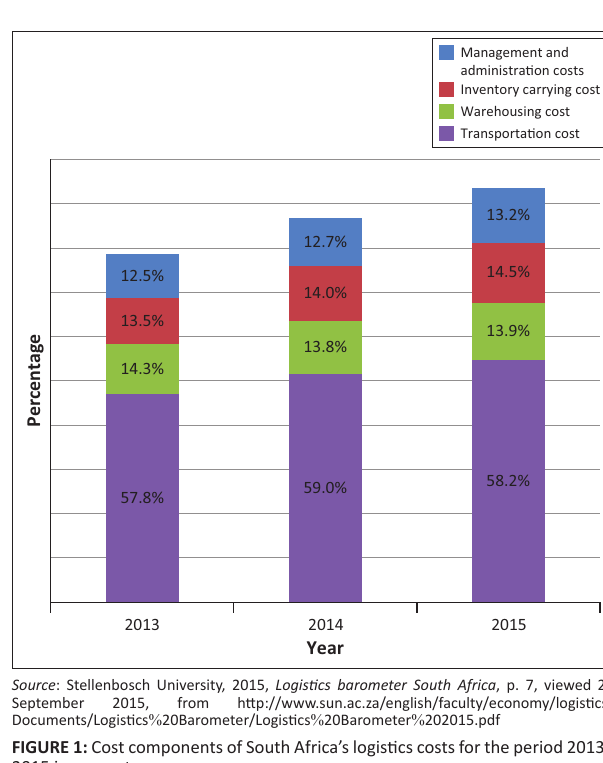
FIGURE 1: Cost components of South Africa’s logistics costs for the period 2013– 2015 in